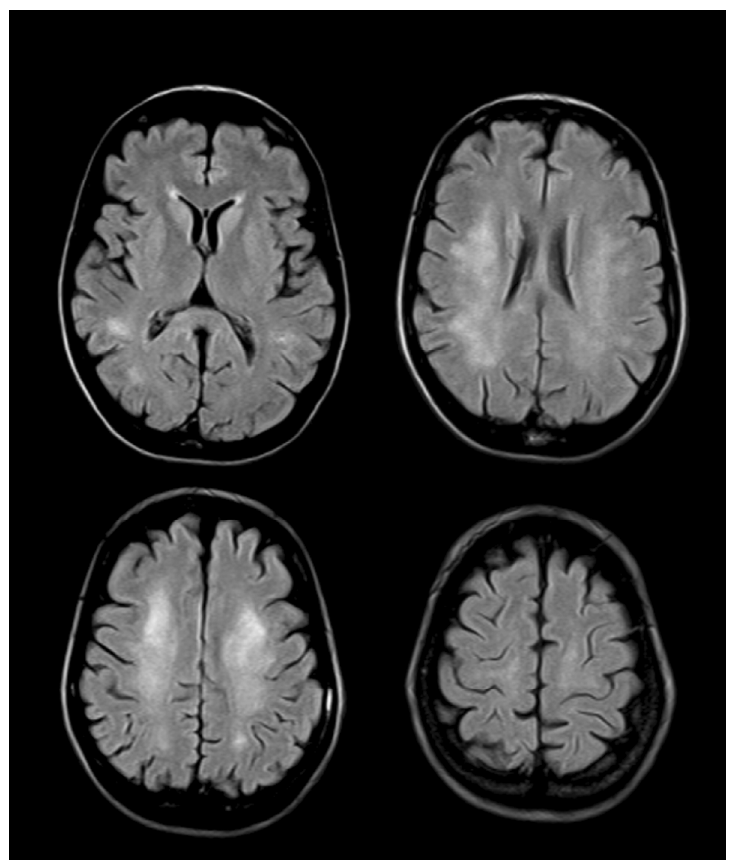
Figure 3. Brain MRI of a 45-year-old female presenting with slowly progressive cognitive impairment. Axial attenuated inversion recovery (FLAIR) images disclose diffuse and symmetric white matter signal